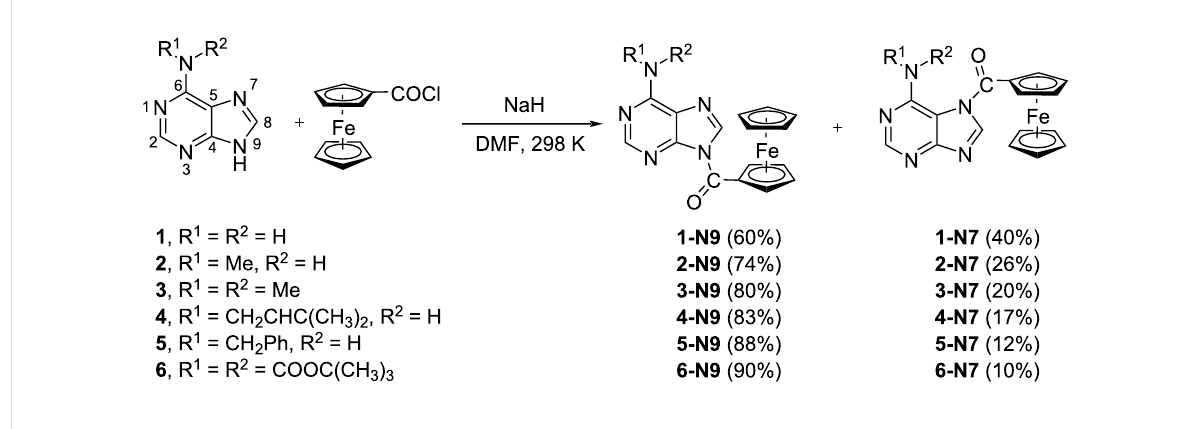
Scheme 1: Regioselective ferrocenoylation of the adenine anion 1 and its derivatives 2 – 6 substituted at the N 6 -position. The respective NMR yields for regioisomers N9 and N7 are shown in parentheses.